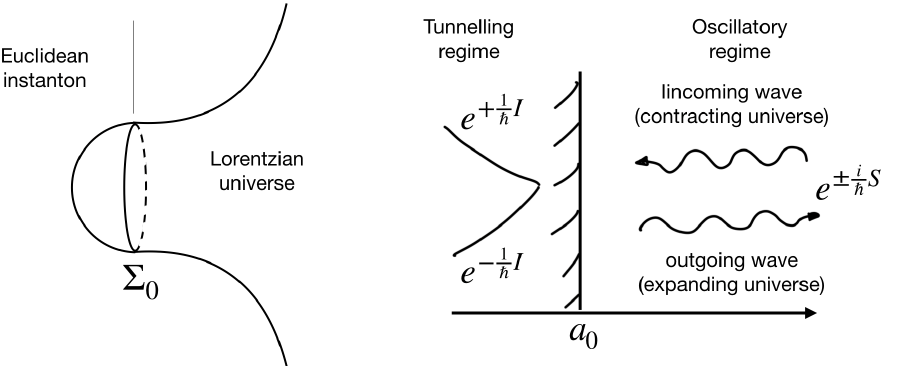
Figure 4. Left: the class C over which the path integral has to be performed is the class of com- pact geometries that have Σ 0 as their only boundary [12]. Right: the tunnelling proposal states that the only modes that survive the quantum barrier are the “outgoing” modes that represent expanding